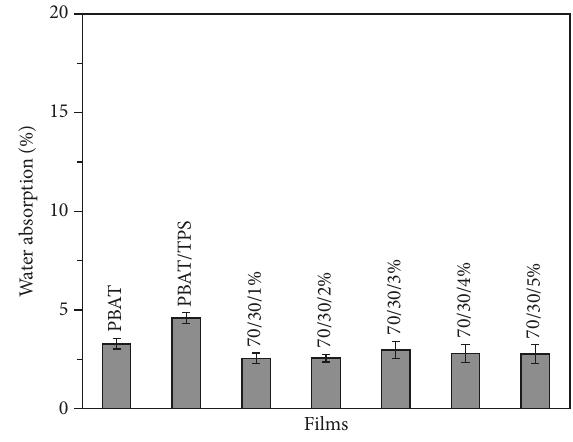
Figure 9: Water absorption of the